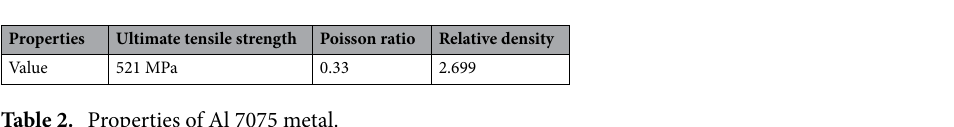
Table 2. Properties of Al 7075